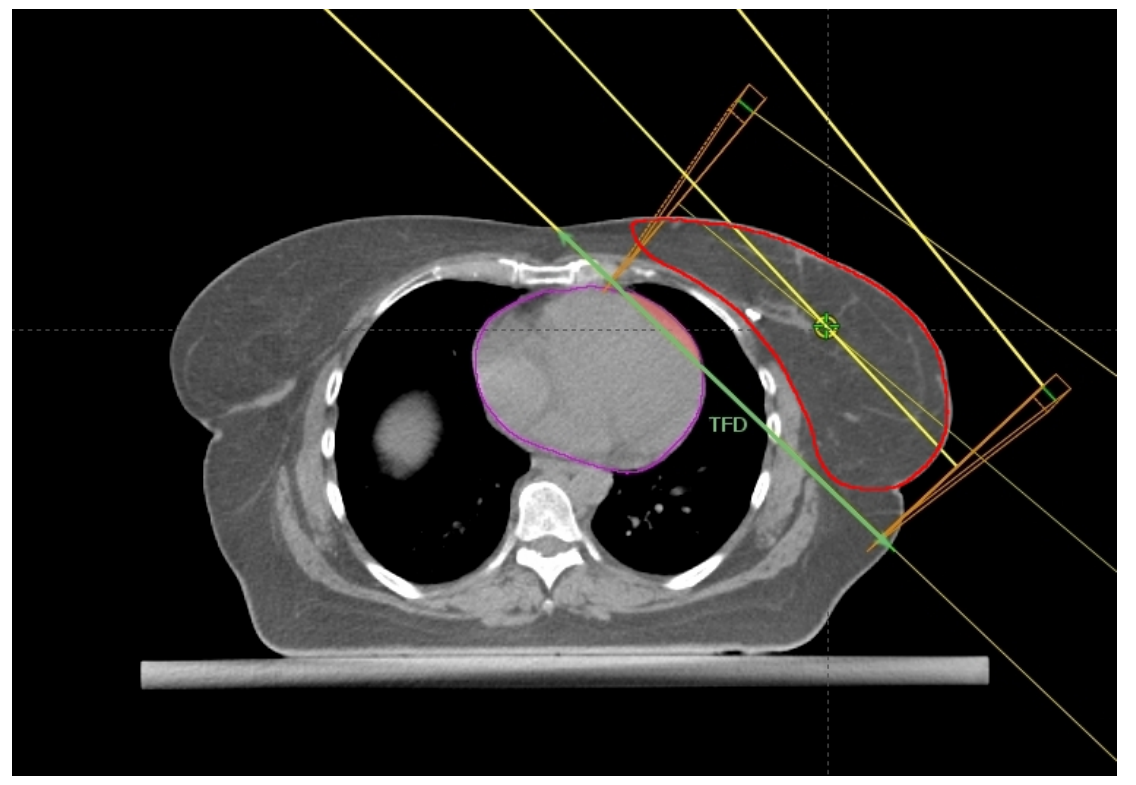
Figure 4. Axial CT plane passing through the liver dome with a standard tangential beam arrangement. The tangential field distance (TFD, green line), HVIF (pink area), and the CTV (red) have been highlighted.